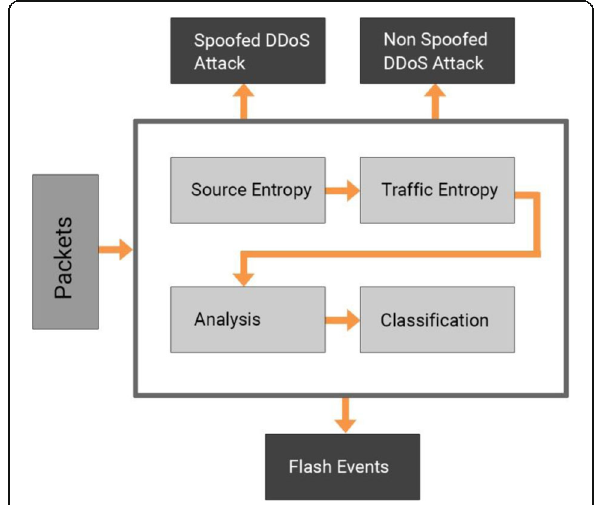
Fig. 1 Overview of the proposed approach using source entropy and traffic entropy is considered for analysis and classification of DDoS attacks into spoofed and non-spoofed attacks besides flash events